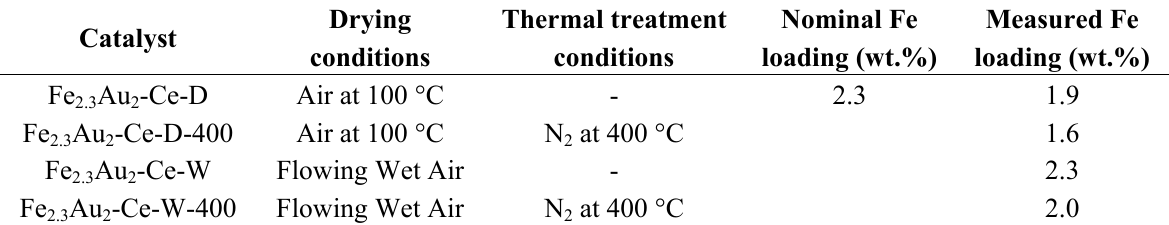
Au -Ce samples pretreated under different conditions. 2.3 2